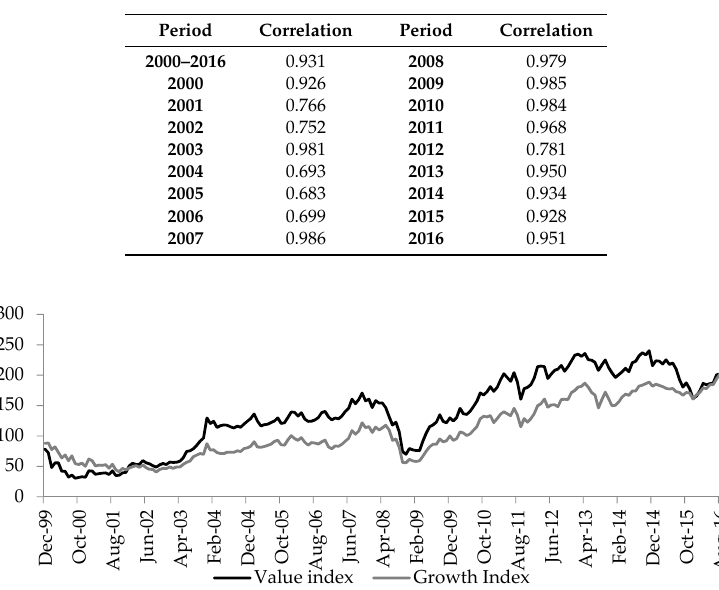
Figure 1. Performance of MSCI Thailand Value Index and MSCI Growth Index (December 1999– December 2016).